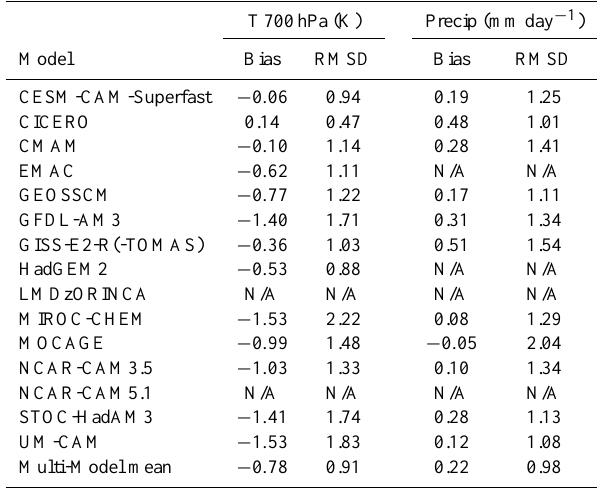
Table 4. Globally-averaged mean bias and root-mean square dif- ference for annual mean 700hPa temperature (K) and precipitation (mm day − 1 ). Note that because of their very similar climate diag- nostics, results from GISS-E2-R and GISS-E2-R-TOMAS are com-